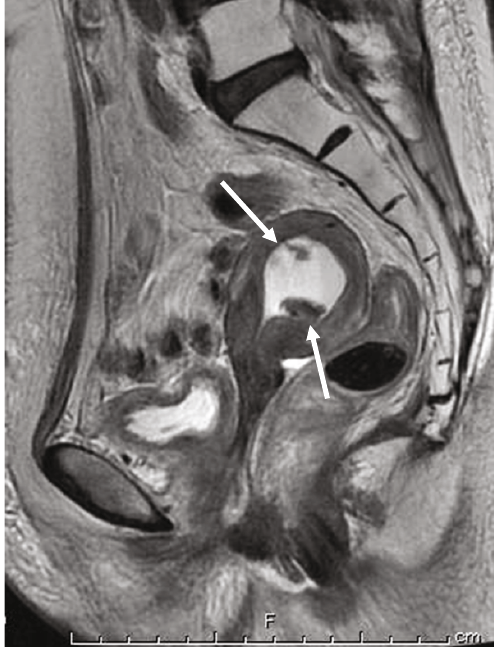
Figure 2: Magnetic resonance imaging (MRI) fi ndings of endometrial tumors arising after pelvic radiation therapy. T2- weighted MRI showing markedly high-intensity liquid and two tumors in the uterine cavity